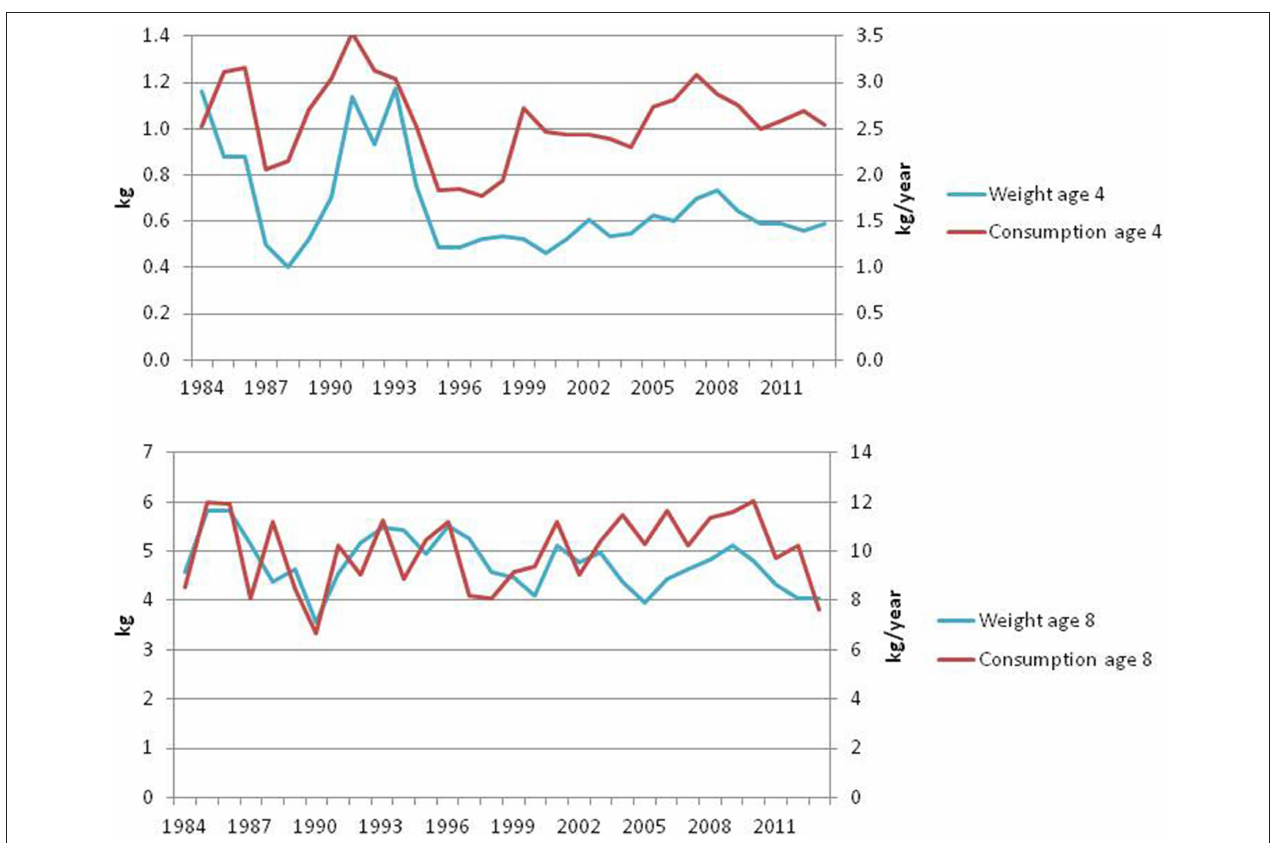
FIGURE 13 | Annual weight at age (kg) and per capita consumption (kg/year) for medium (age 4) and large (age 8) cod (ICES,